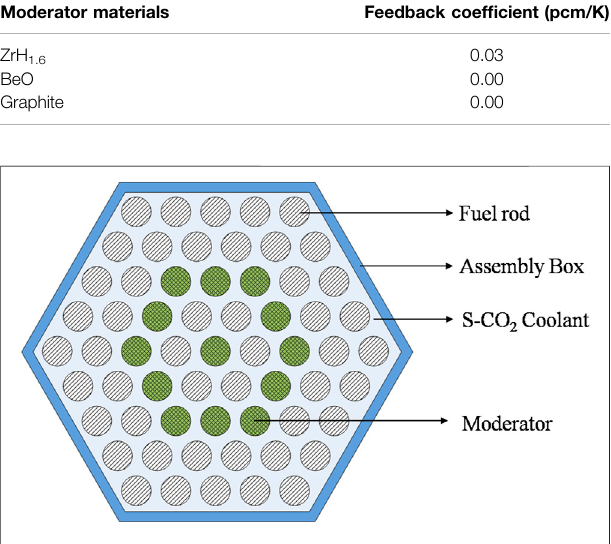
FIGURE 10 | S-CO 2 fuel assembly with moderator (circular